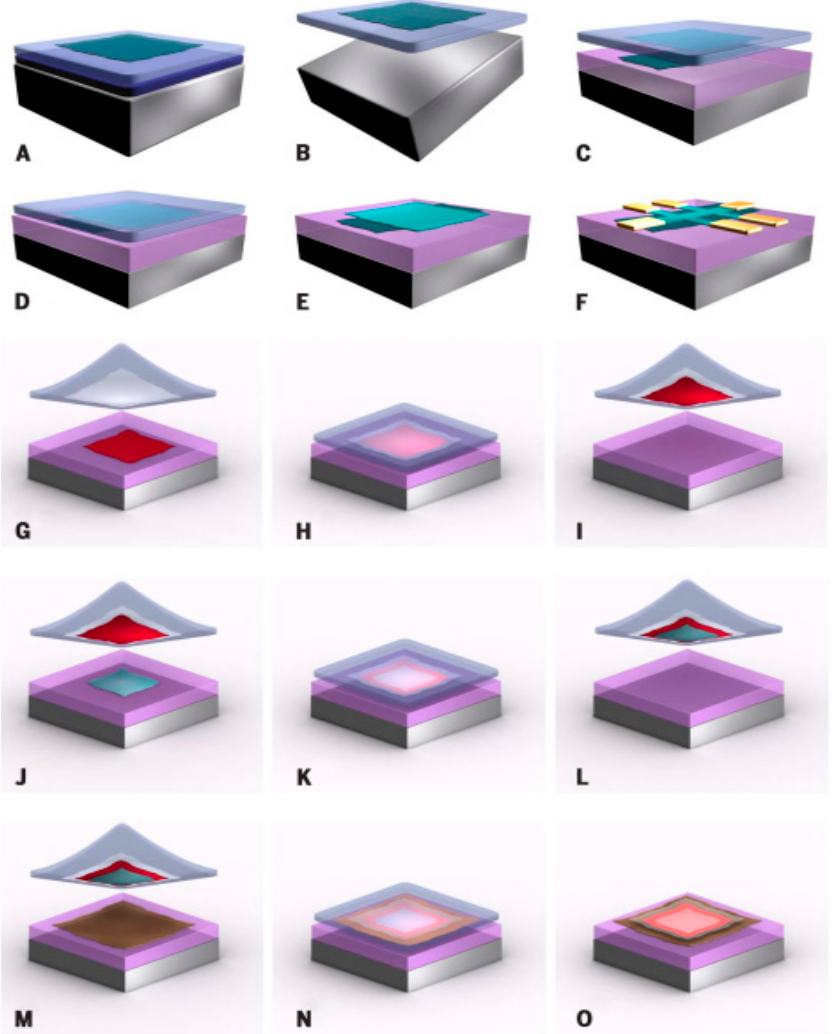
Figure 3. Assemble van der Waals heterostructures techniques: wet-transfer and pick-and-lift. ( A – F )